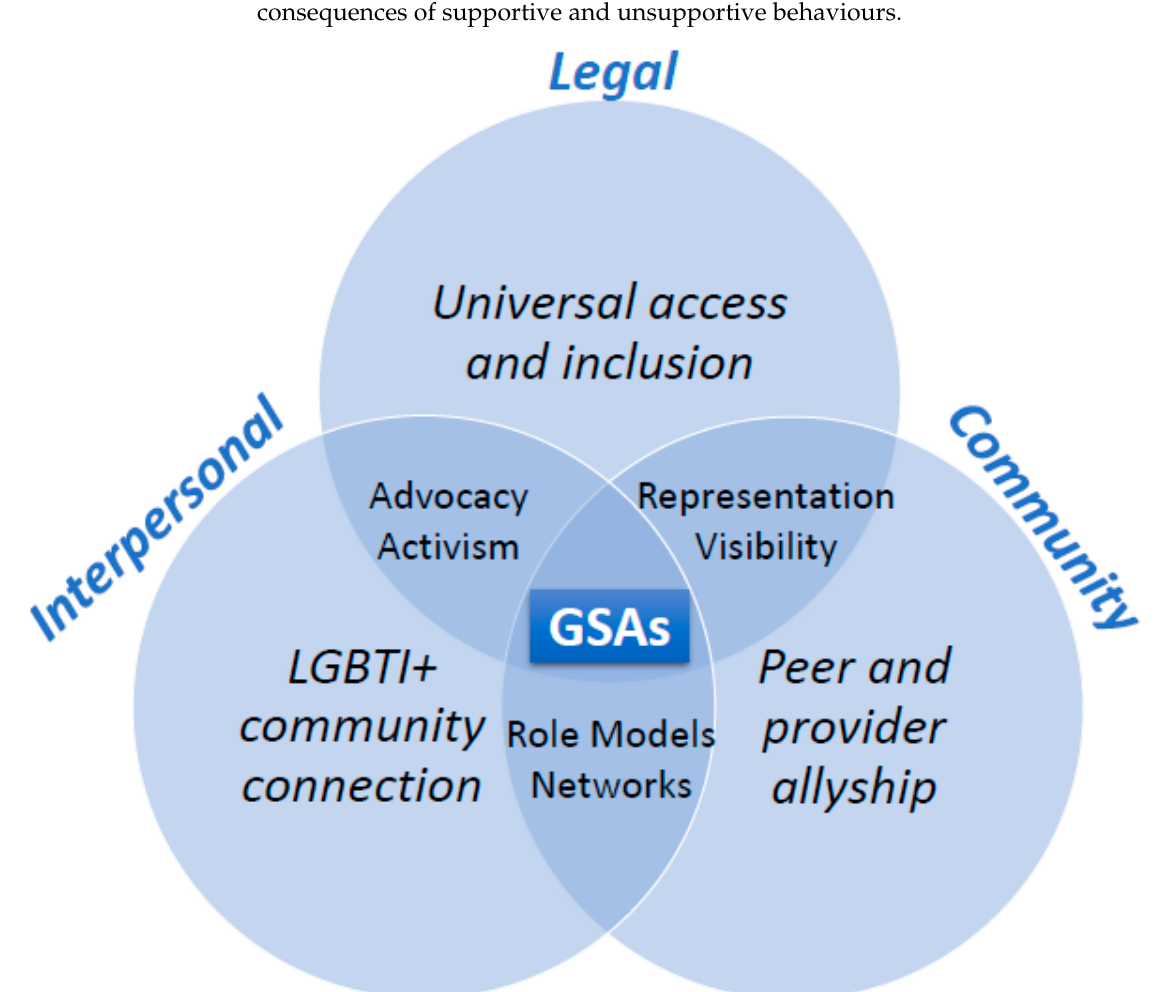
Figure 7. The association of Gay-Straight Alliances / Gender-Sexuality Alliances (GSAs) with intersecting interpersonal, community and legal protective factors.